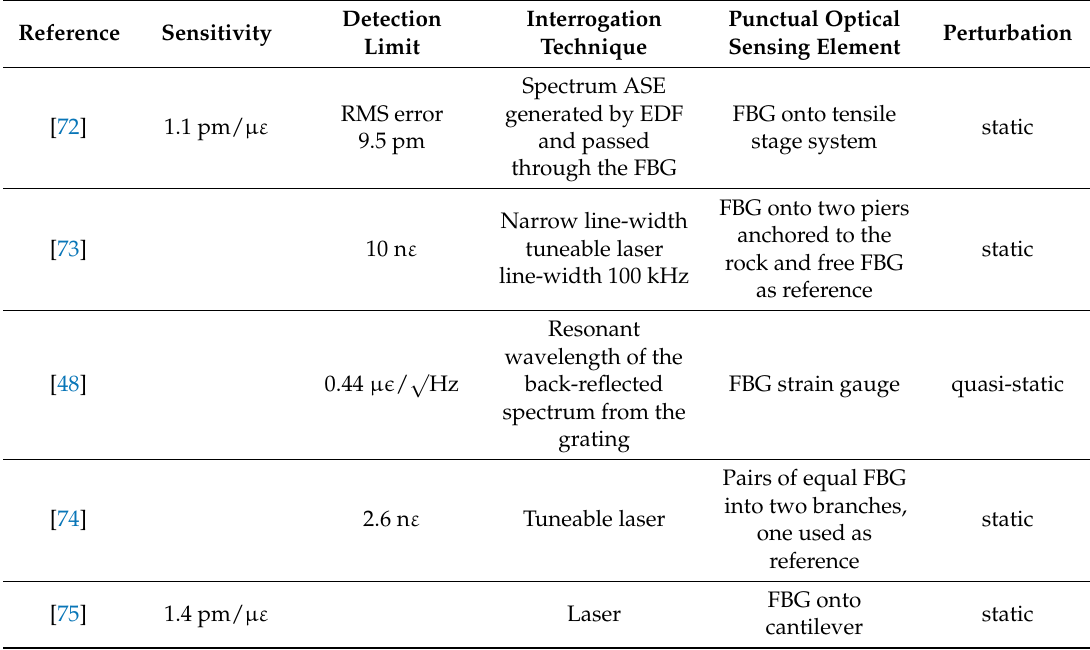
Table 3. Applications at research